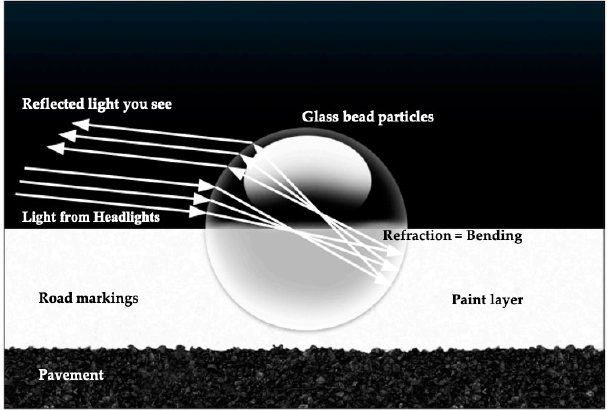
Figure 21. Retroreflective mechanism of glass beads used in highway road paints (modified from [235]).